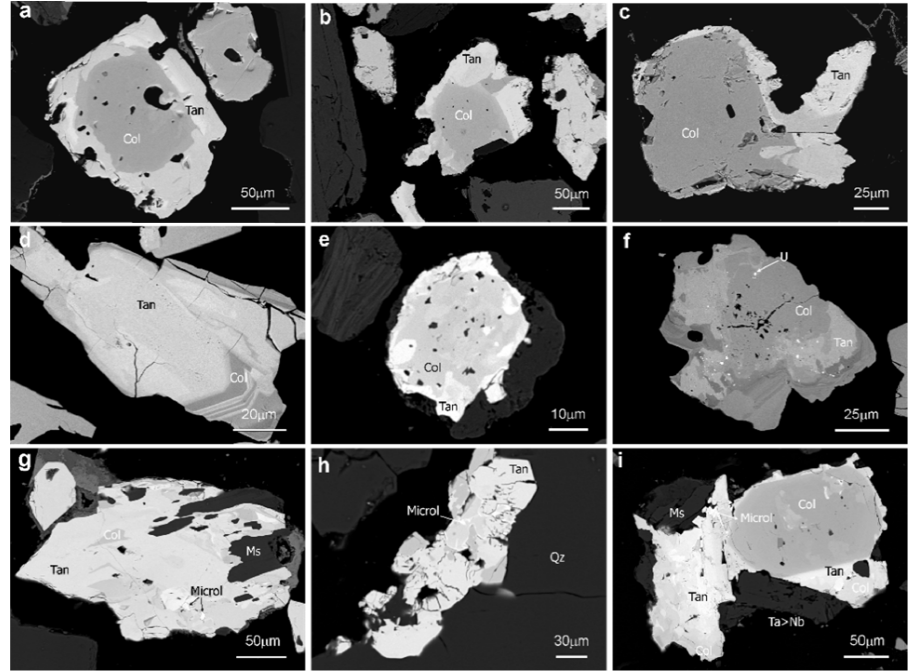
Figure 8. Columbite group minerals from the Penouta tailings showing different textures and associations: ( a – c ), concentric zoning; ( d ) oscillatory zoning; ( e ) patchy zoning; ( f ) presence of oscillatory zoning including uraninite microcrystals; and ( g – i ) association with microlite. Col, columbite; Tan, tantalite; Microl, microlite; Qz, quartz, Ms, muscovite; and U, uranium.